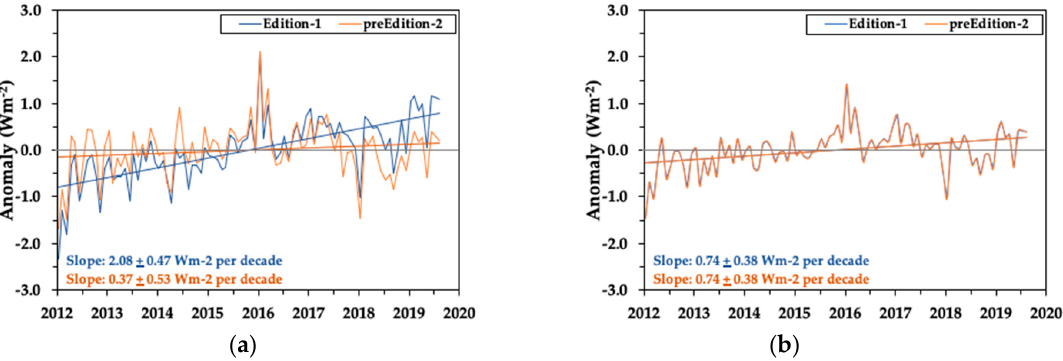
Figure 2. LW global all-sky flux anomalies for the period February 2012–September 2019 using the SSF-1deg products for: ( a ) Terra using the Edition-4 data product; ( b ) Aqua using the Edition-4 data product; and ( c ) S-NPP using the Edition-1 data product. Additionally, shown is the difference between the individual instrument anomalies and the anomaly of the average of the three instruments. Uncertainties in slope correspond to 95% confidence intervals.